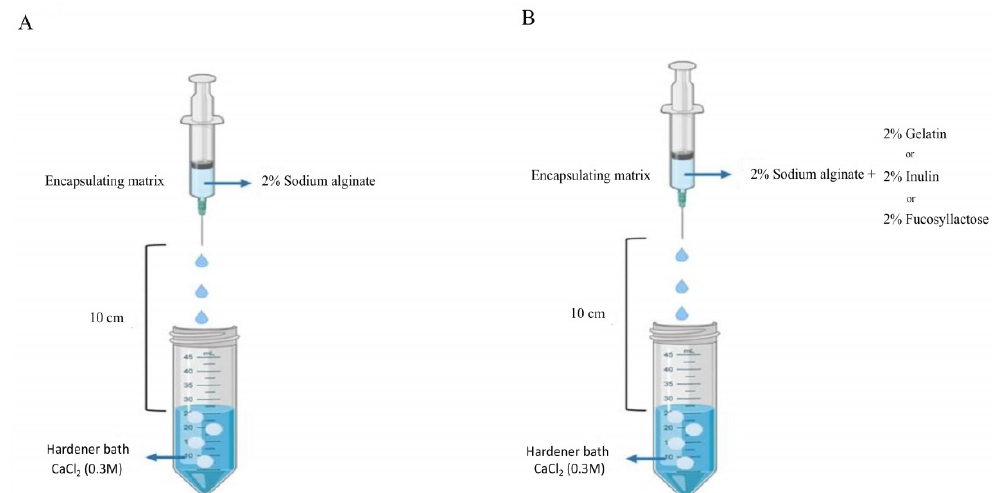
Figure 1. Scheme of microencapsulation procedure of S. thermophilus TH982 cells using the extrusion technique. ( A ) The sodium alginate alone as control. ( B ) Sodium alginate with other agents.